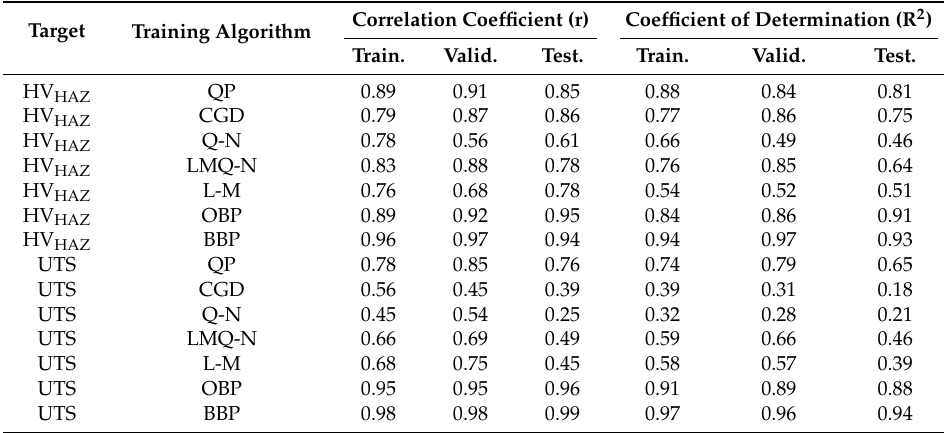
Table 4. Performance of the ANN adopting different learning